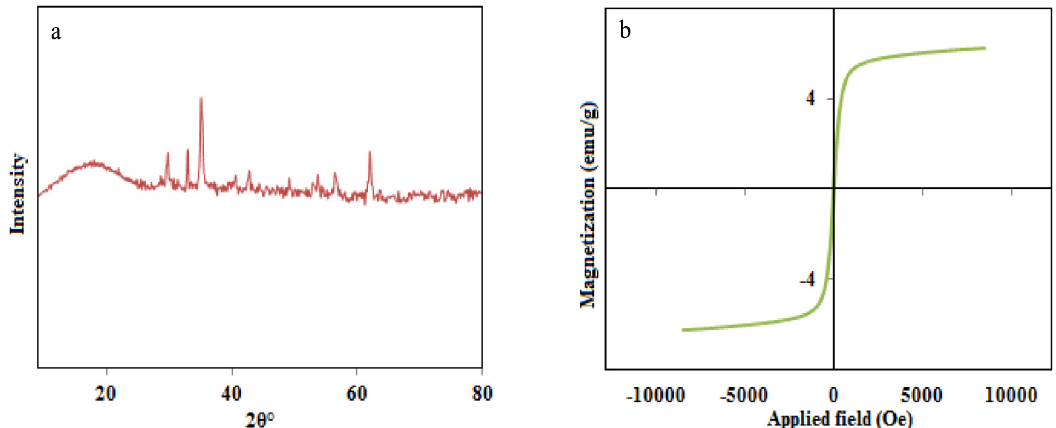
Fig. 1 . XRD pattern (a), and VSM graph (b) of as synthesized magnetic